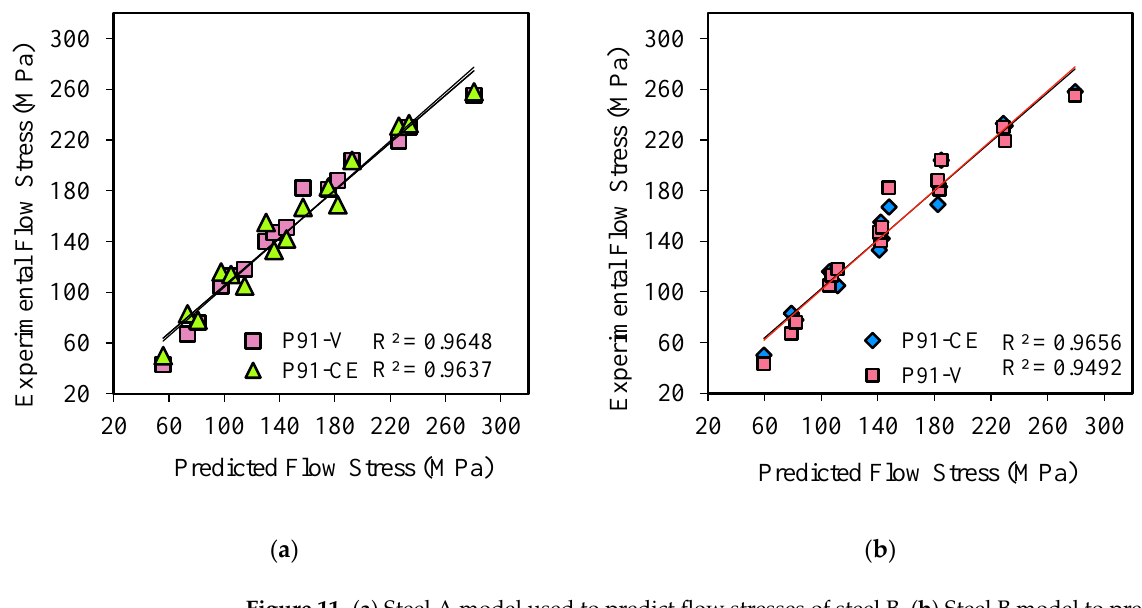
Figure 11. ( a ) Steel A model used to predict flow stresses of steel B. ( b ) Steel B model to predict flow stresses in Steel A.